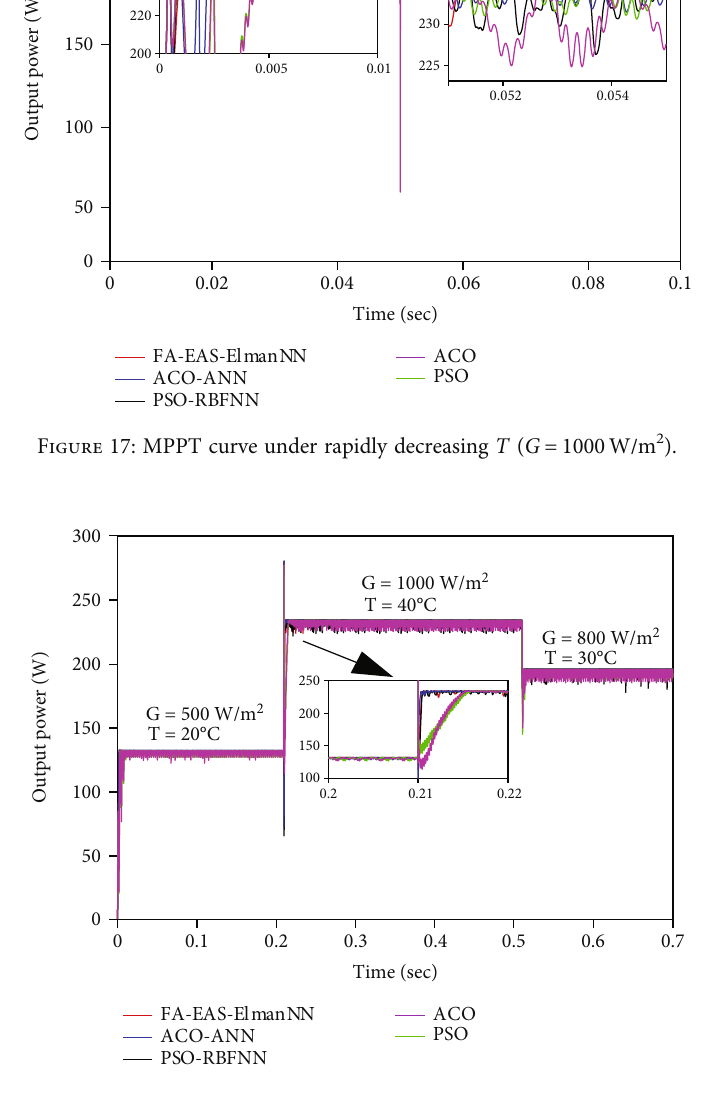
Figure 18: Output power of PV array under rapidly changing G and T